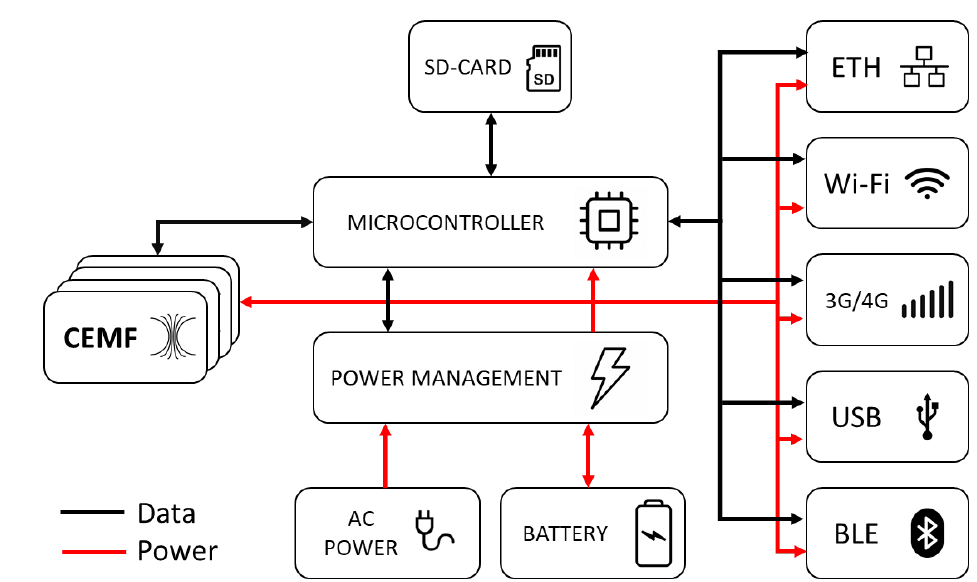
Figure 2. CEMF sensor architecture.